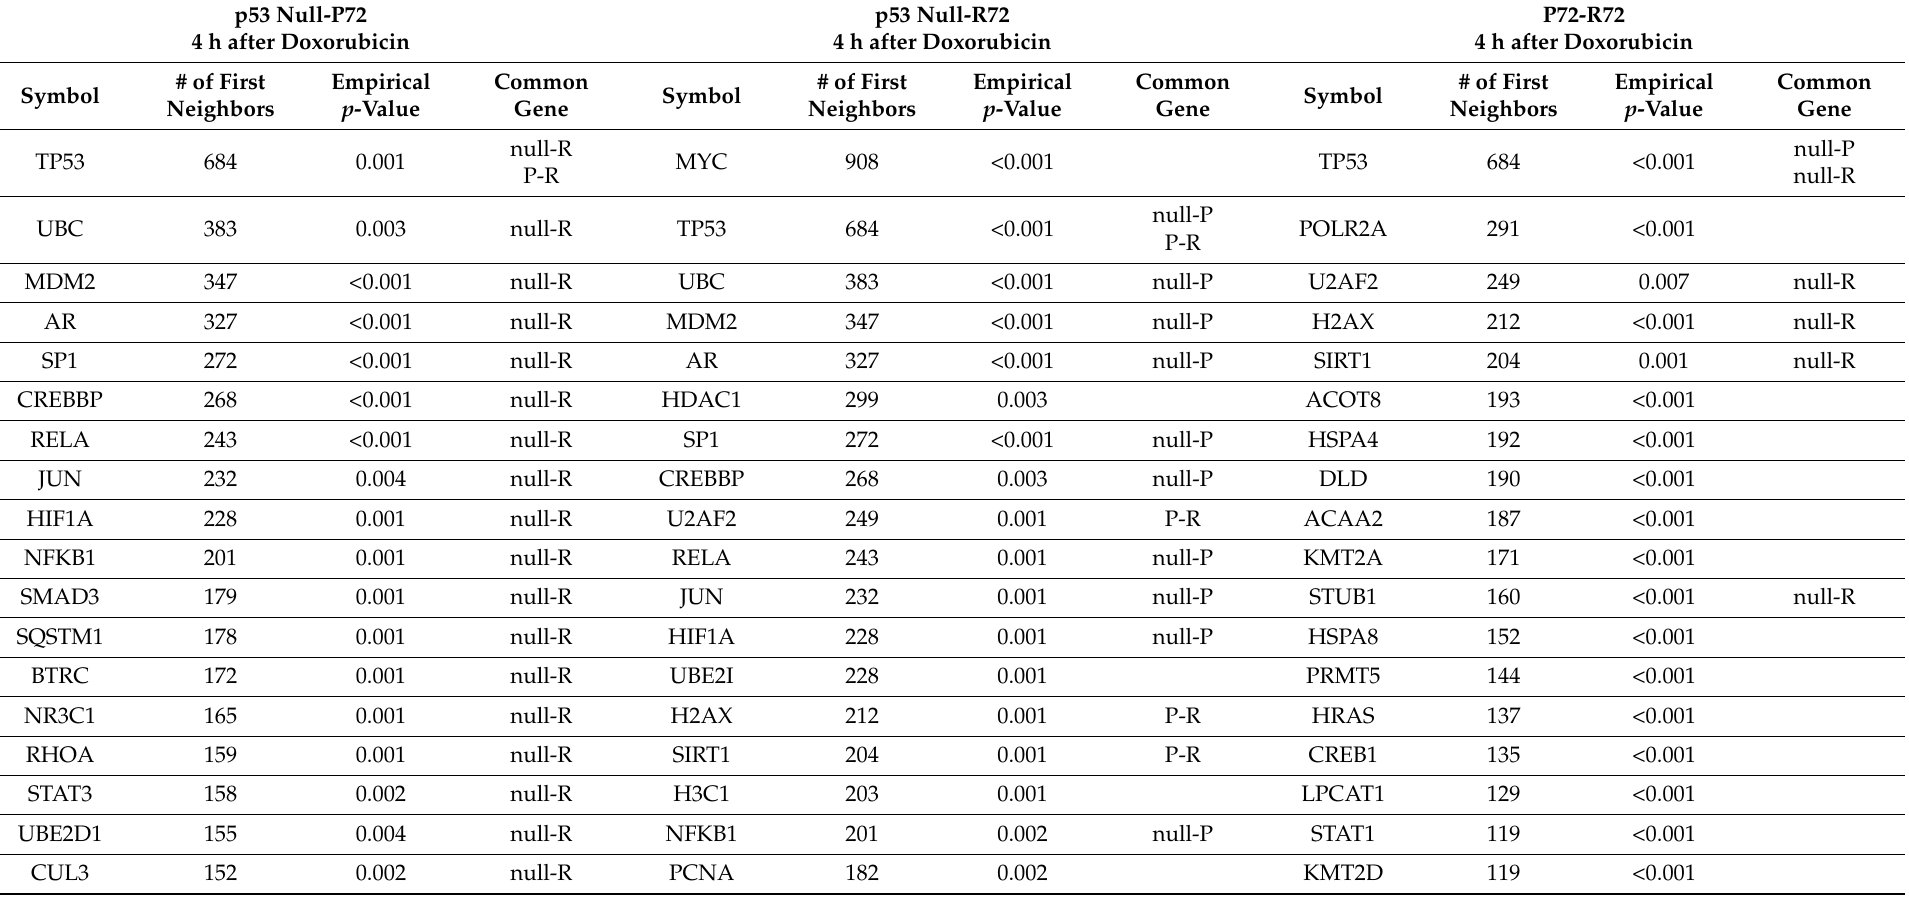
Table 1. Selected list of core DEGs. The top 50 genes are displayed in order of number of the first neighbor of a given gene in the interaction network. Common genes between key DEGs were shown; “null-P” represents core DEGs between p53 null and P72 cells. “null-R” represents core DEGs between p53 null and R72 cells. “P-R” represents core DEGs between P72 and R72